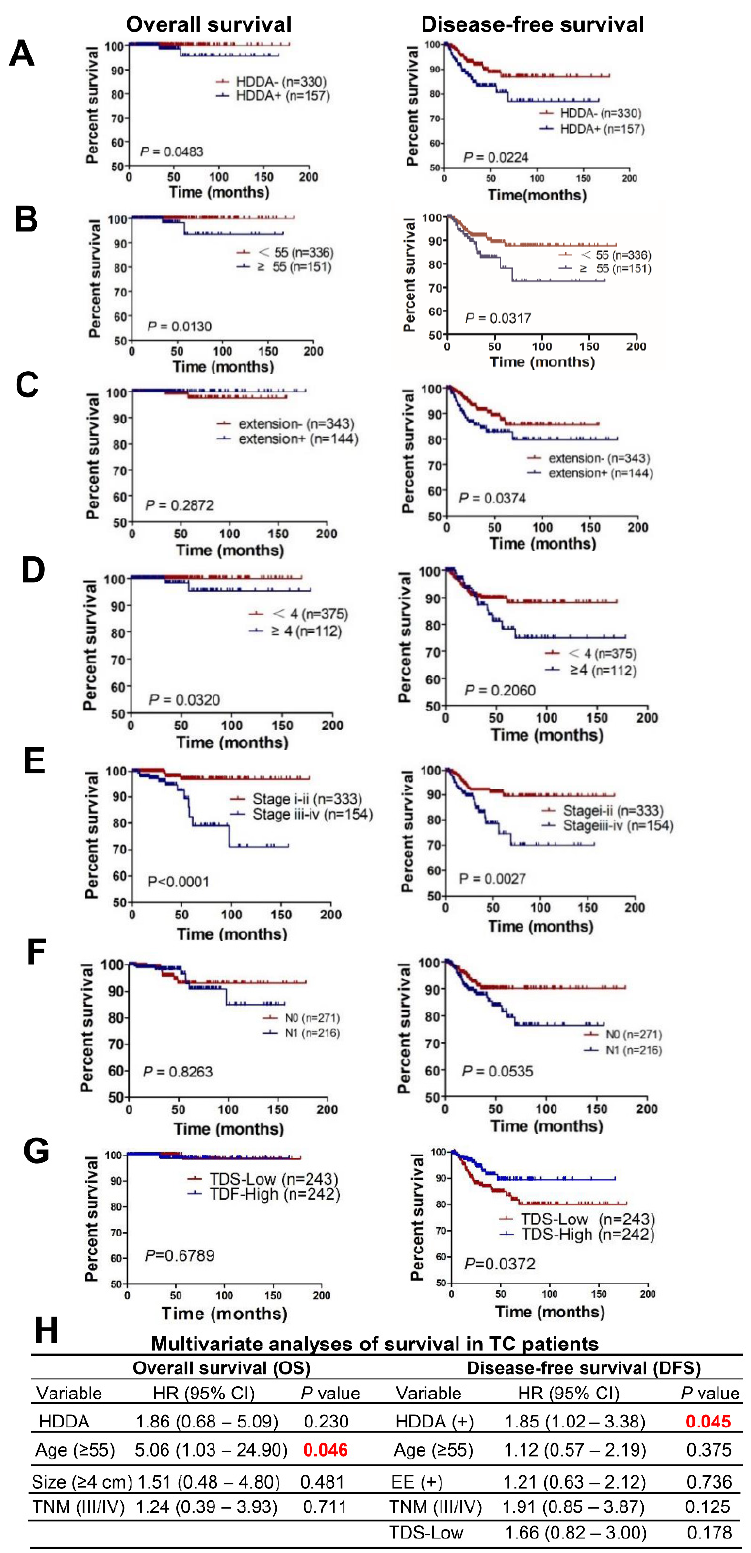
Figure 2. Highly drifted DNAm age (HDDA) independently predicts shorter patient disease-free survival (DFS) in TCs. ( A – G ) HDDA, chronological age, extrathyroidal extension, tumor size, N and TNM stages, and thyroid differentiation score (TDS) for their association with OS and DFS, respectively. ( H ) Multivariate analyses of the variables above for association with OS and DFS. EE: Extrathyroidal extension. P values in red: Statistically